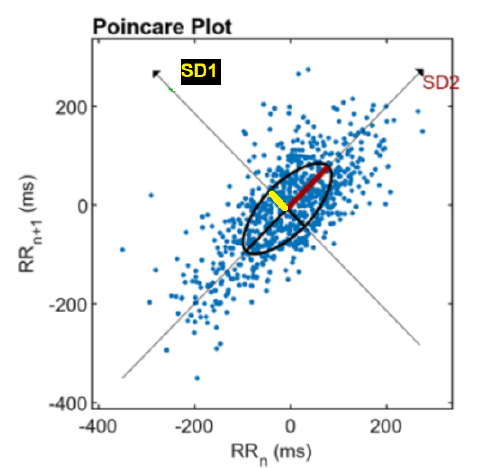
Figure 5. Poincaré plot analysis with the ellipse fitting procedure. SD1 and SD2 are the standard deviations in the directions x 1 and x 2 . Adapted with permission from [35]. 2016–2021 Kubios